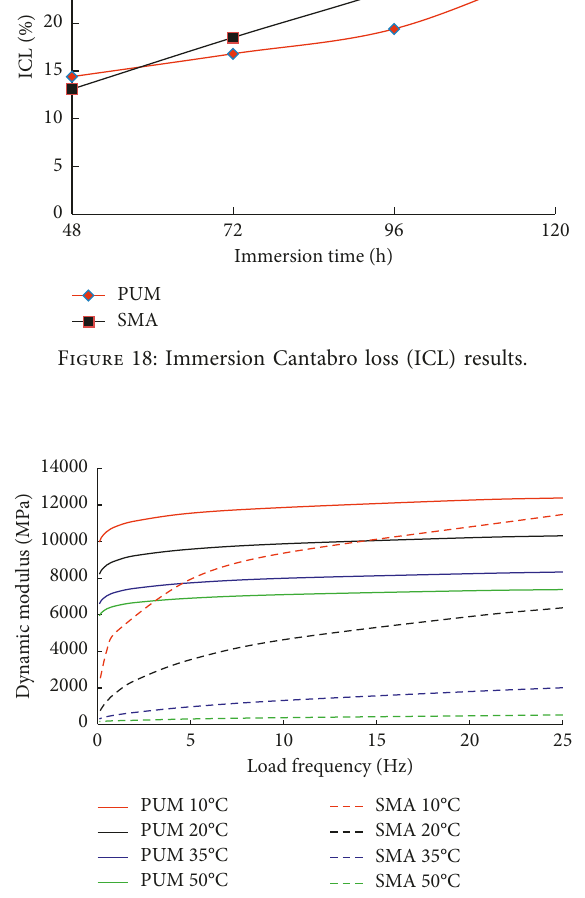
Figure 19: Dynamic modulus of the two mixtures. Figure 21: Natural gas consumption and CO